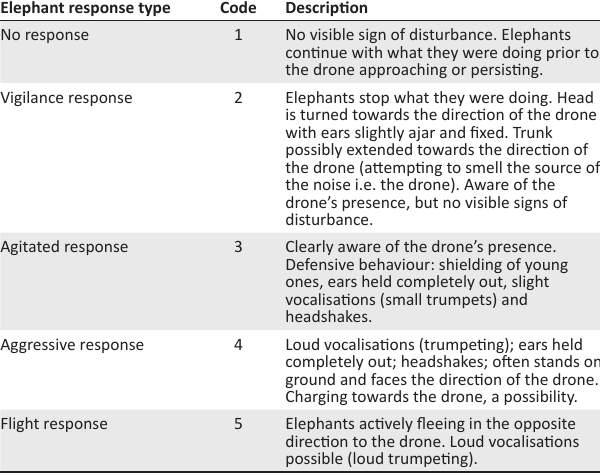
TABLE 2: The various possible elephant responses recorded during both the approach and presence data collection. Elephant response type